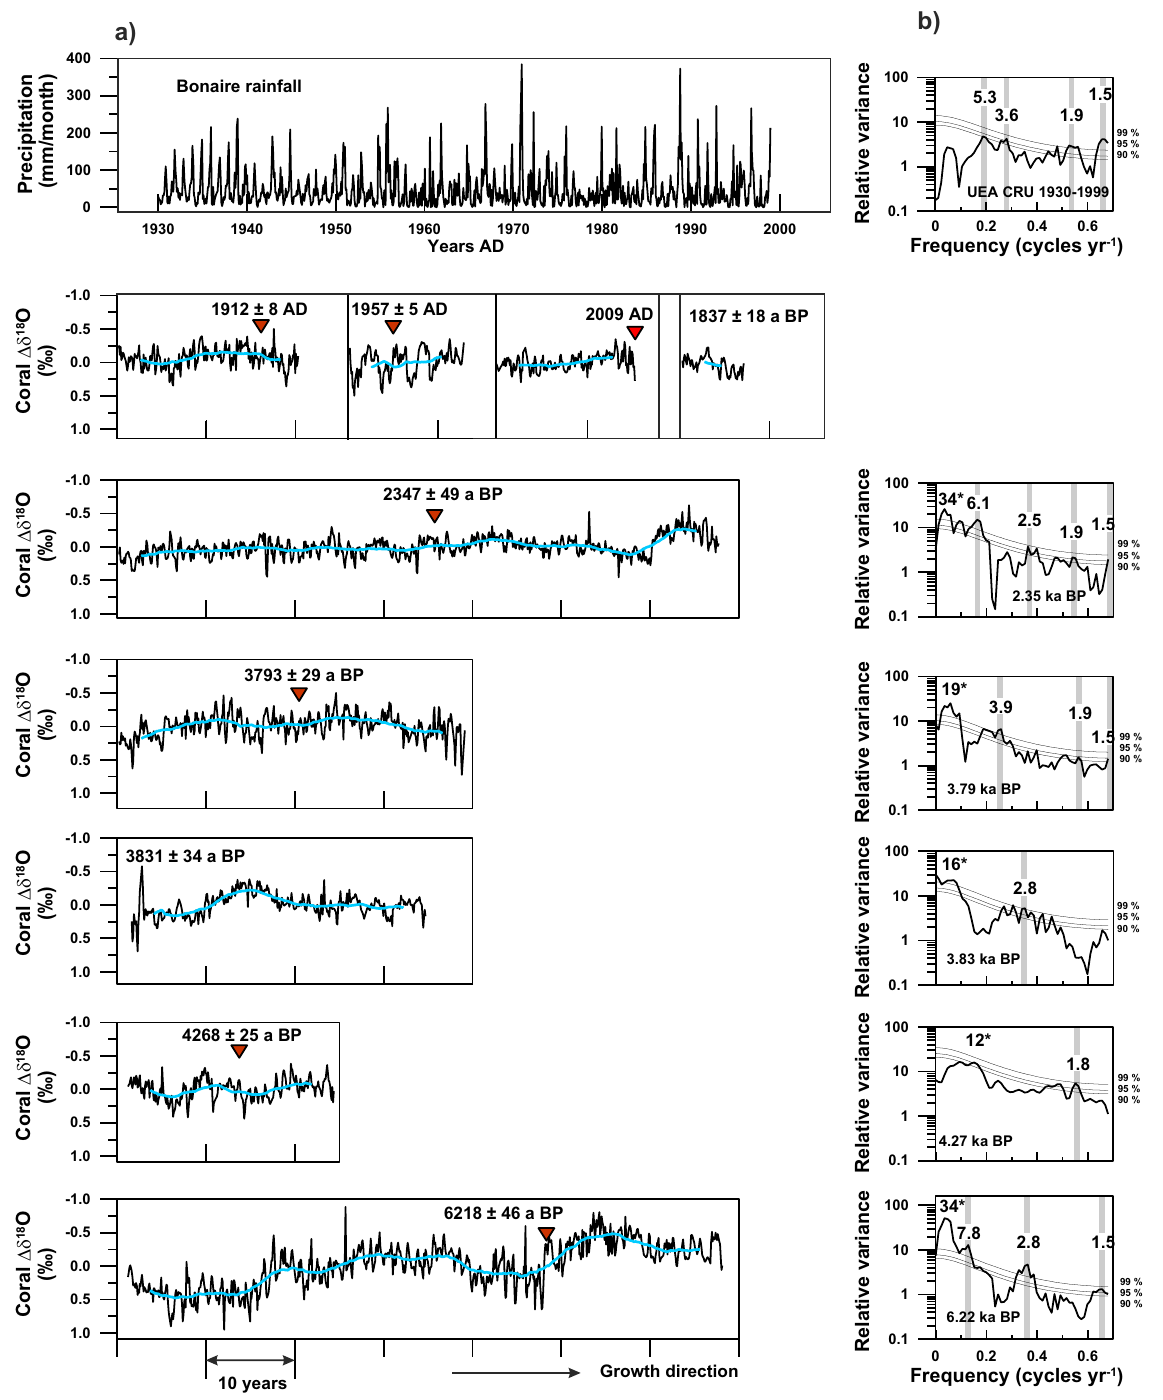
Fig. 7. (a) Monthly rainfall record from gridbox centred on Bonaire (12.5 ◦ N; 67.5 ◦ W) (top panel) (Hulme et al., 1998) and monthly reconstructed coral 1δ 18 O records from Bonaire corals calculated using the centering method (Cahyarini et al., 2008). Thick blue lines represent the 5-yr running average. Sr/Ca-SST and δ 18 O–SST regression coefficients used are − 0.061 and − 0.180mmolmol − 1 ◦ C − 1 , respectively. U-series ages of fossil corals (Giry et al., 2012) are indicated. (b) Multitaper method (MTM) spectral analysis (significance relative to a red noise null hypothesis determined with the robust method of noise background estimation; Ghil et al., 2002; Mann and Lees, 1996; number of tapers 3; bandwidth parameter 2) of detrended and normalised monthly precipitation and coral 1δ 18 O records with length > 20yr where the mean annual cycle has been removed. Ninety (90), 95, and 99% confidence levels are indicated. Significant spectral peaks are labelled. Asterisks indicate periodicities at the limit of detection with respect to the length of the time series, where oscillatory behaviour becomes indistinguishable from a secular